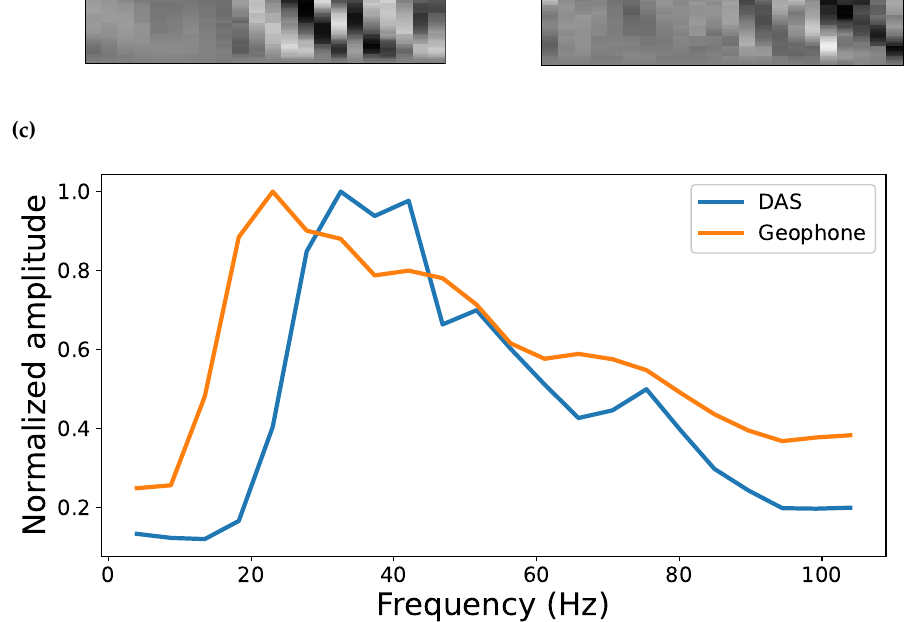
Figure 6. Representative shot gathers recorded on ( a ) vertical-component geophones and ( b ) DAS fiber array (after 2D velocity-dip filtered). ( c ) Normalized magnitude spectrum of the two shot gathers presented in ( a , b